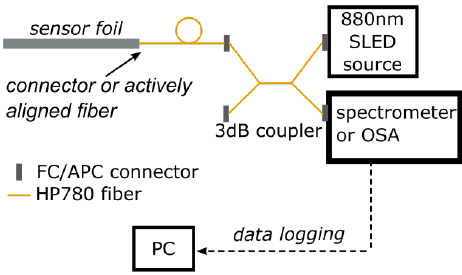
Figure 4. System for reading out Bragg grating sensor foils.